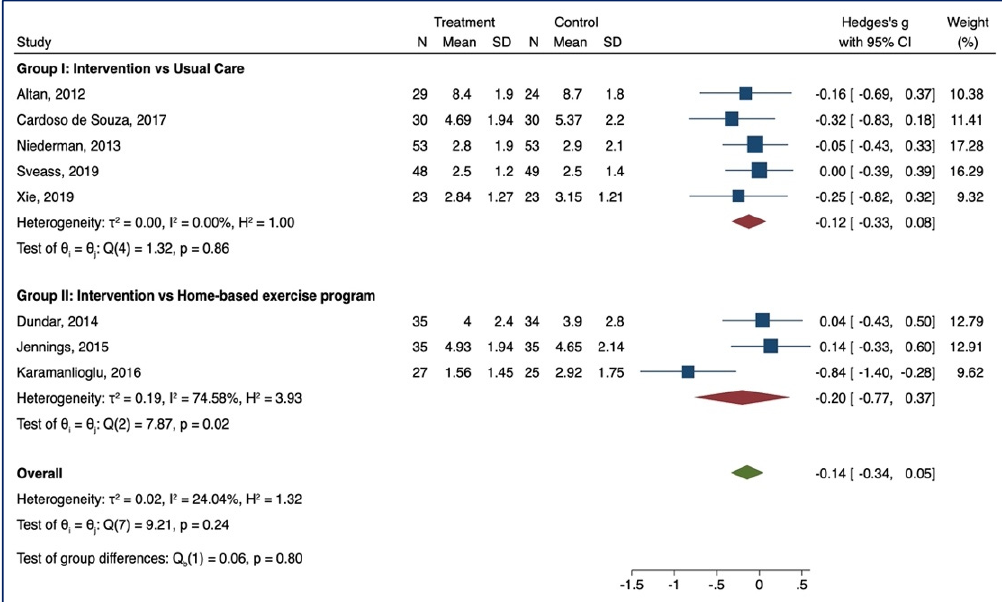
Figure 4. BASMI—Forest Plot.